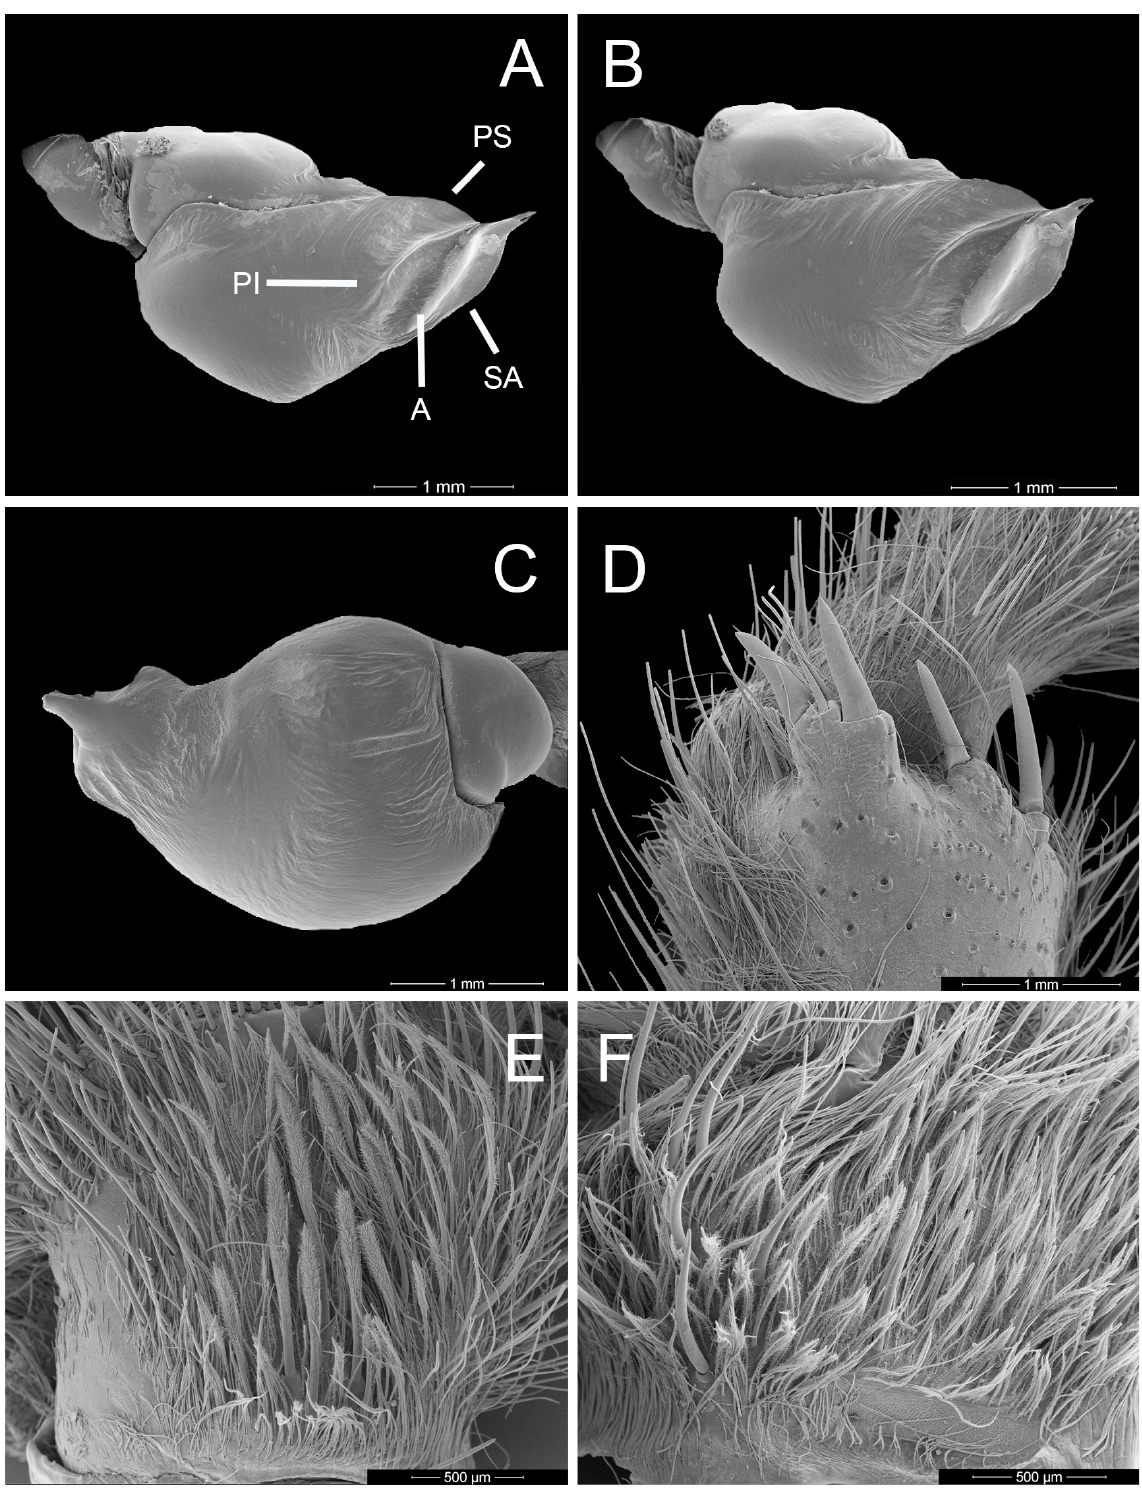
Fig. 12. Umbyquyra palmarum (Schiapelli & Gerschman, 1945) gen. et comb. nov. ♂, Canoa Quebrada, Mato Grosso, Brazil (IBSP 167427). A . Palp prolateral. B . Anterolateral. C . Retrolateral. D . Tibial apophysis, retrolateral. E . Stridulatory organ, palp trochanter. F . Trochanter I. Abbreviations: see Material and